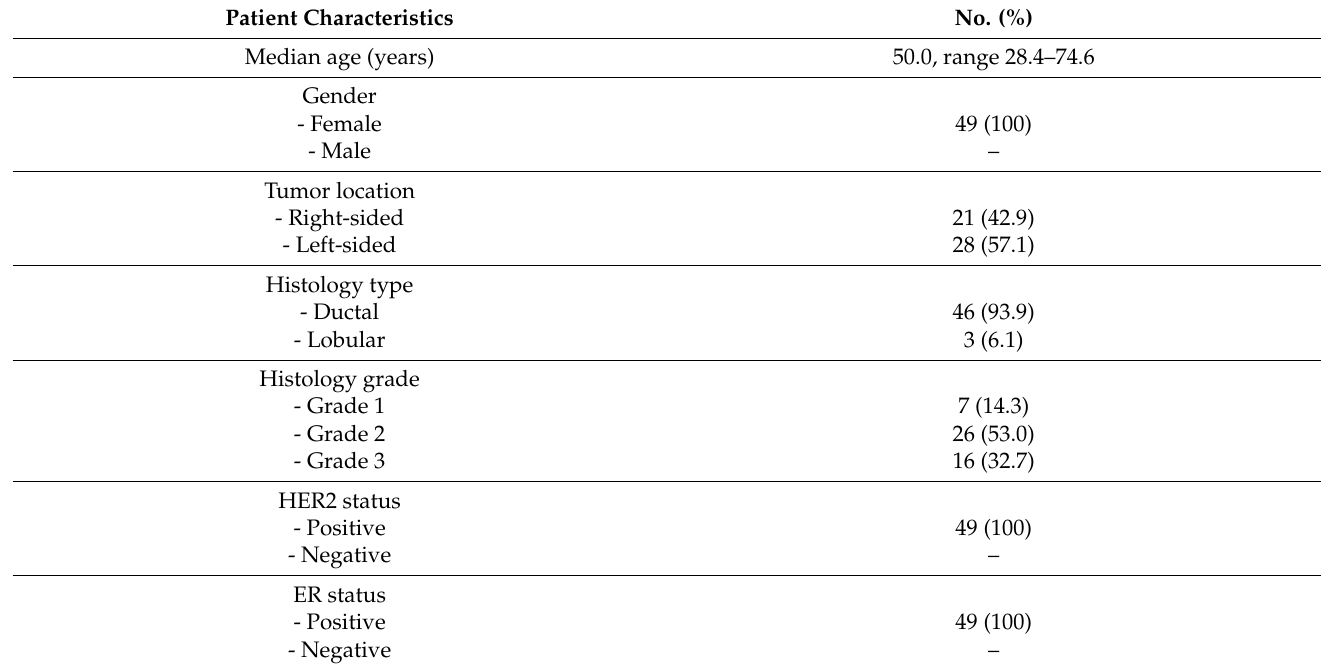
Table 2. Baseline characteristics of the 49 patients enrolled in this